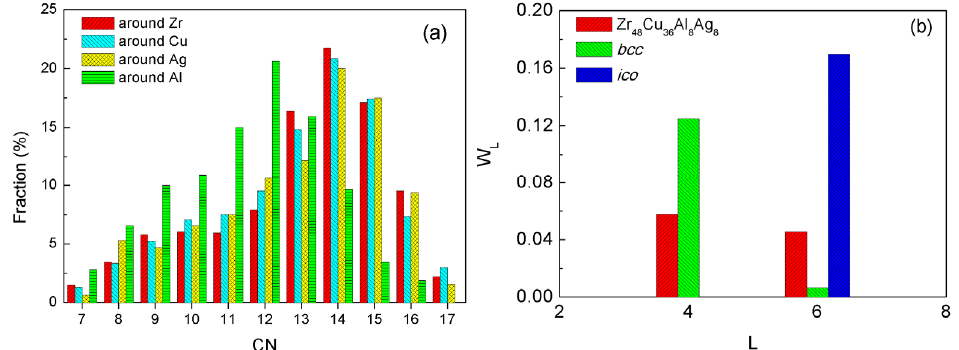
Figure 2. Distribution of ( a ) CN around Zr, Cu, Ag and Al atoms and ( b ) BOO parameters in Zr 48 Cu 36 Al 8 Ag 8 BMG (red columns).